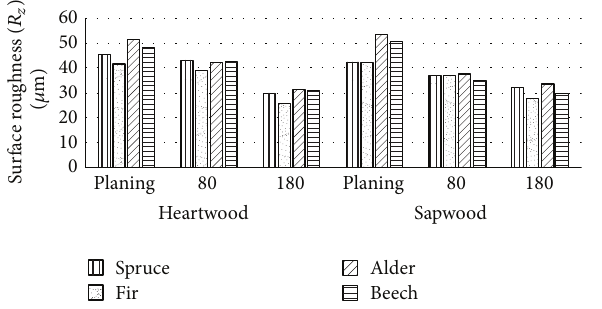
Figure 1: Mean peak-to-valley values of samples.